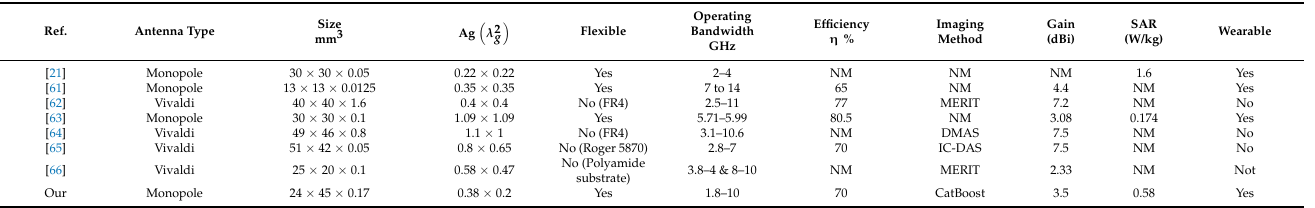
Table 6. Comparison of proposed antenna and others reported in the literature (* work presented in the